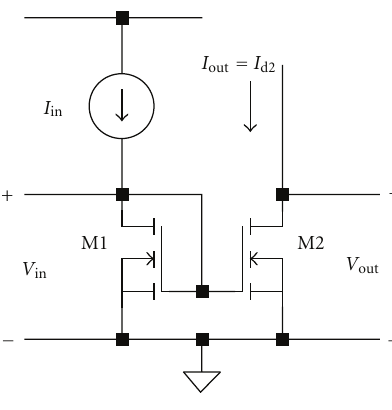
Figure 4: NMOS current mirror.